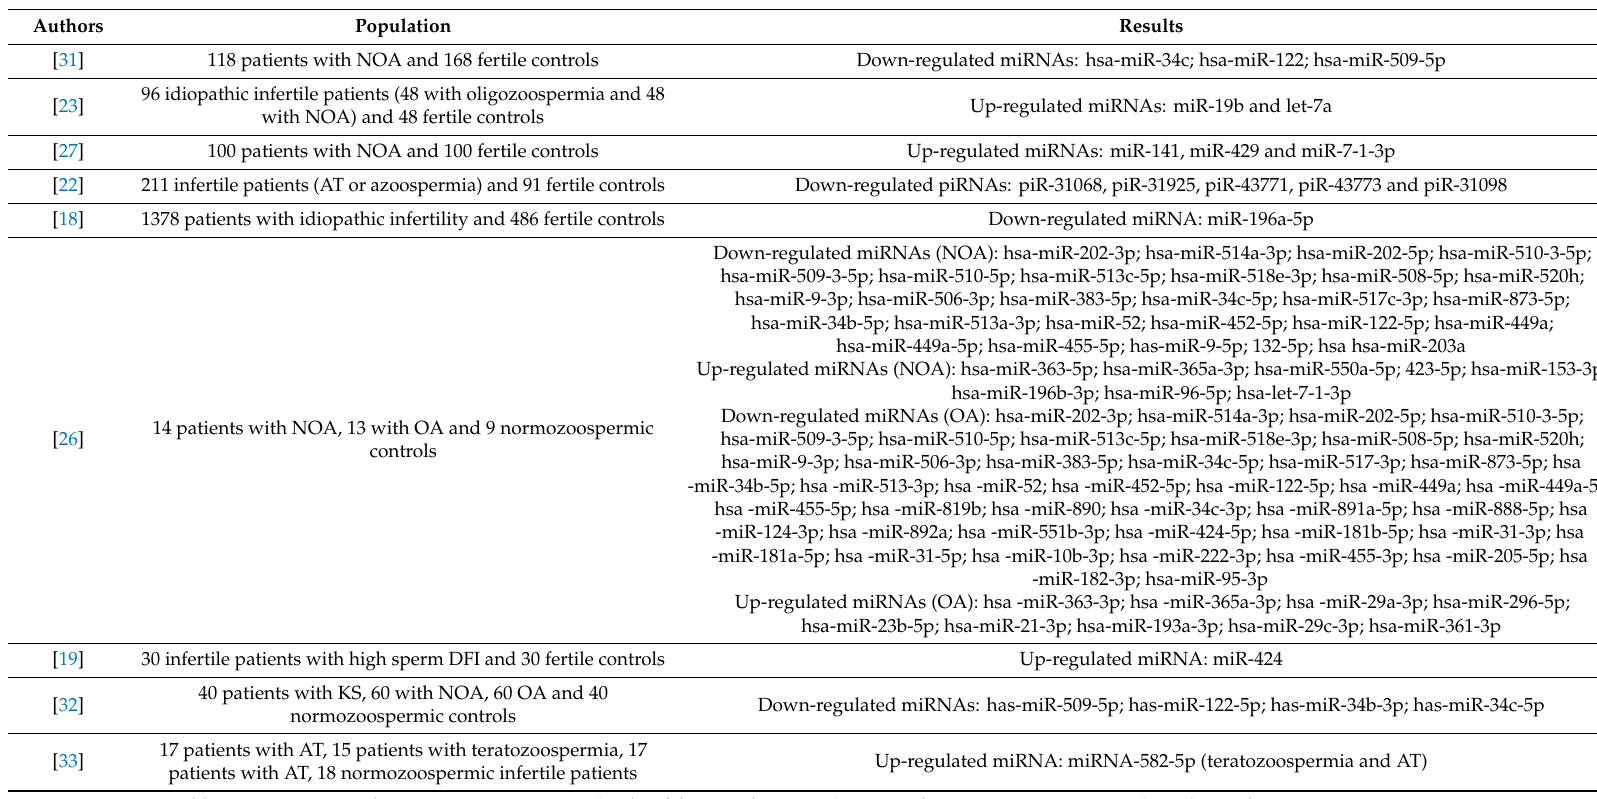
Table 1. Expression profile of human transcripts in seminal plasma of infertile patients and fertile